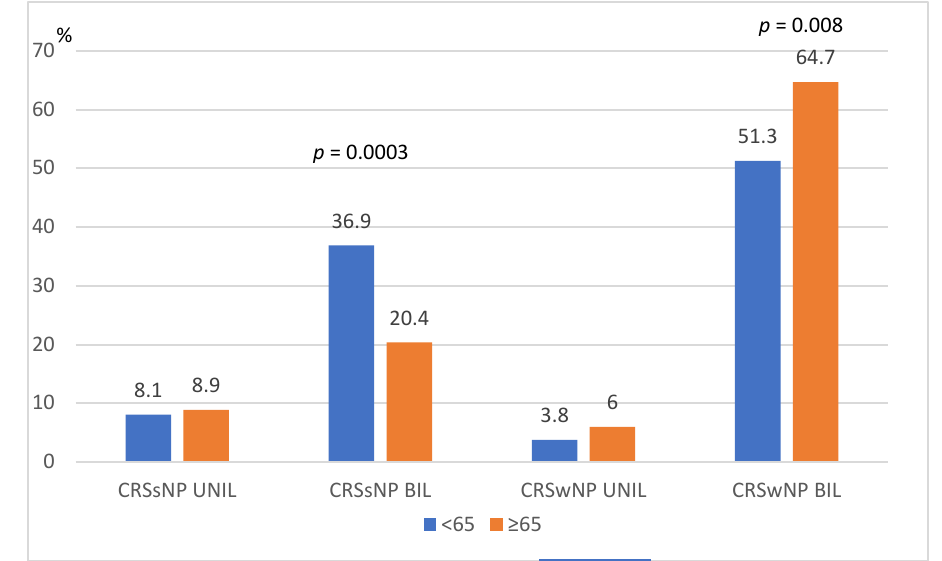
Figure 1. Rhinosinusitis phenotypes in groups of patients < and ≥65 years of age. The neutrophils and lymphocytes counts, as well as NLR, were compared between the whole groups as well as phenotypes in the groups ≥ and <65 years of age ( Table 1). The neutrophils and lymphocytes counts were significantly higher in the group ≥65 years of age (Figures 2 and 3). Table 1. Assessment median and IQR of neutrophils, lymphocytes and NRL in various phenotypes in the groups ≥ and <65 years of age.